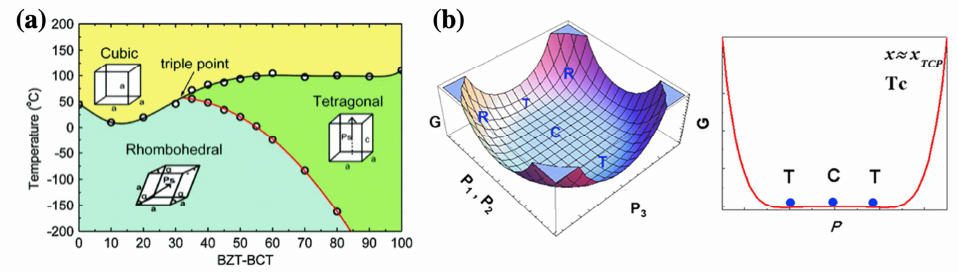
Figure 3. ( a ) Phase diagram of BZT–BCT system. Reprinted with the permission of [43]. Copyright © 2009 American Physical Society. ( b ) The (1 1 0) projection of the free energy profiles for BZT–BCT system and 2D free energy profiles. Reprinted with the permission of [44]. Copyright © 2016 Elsevier.